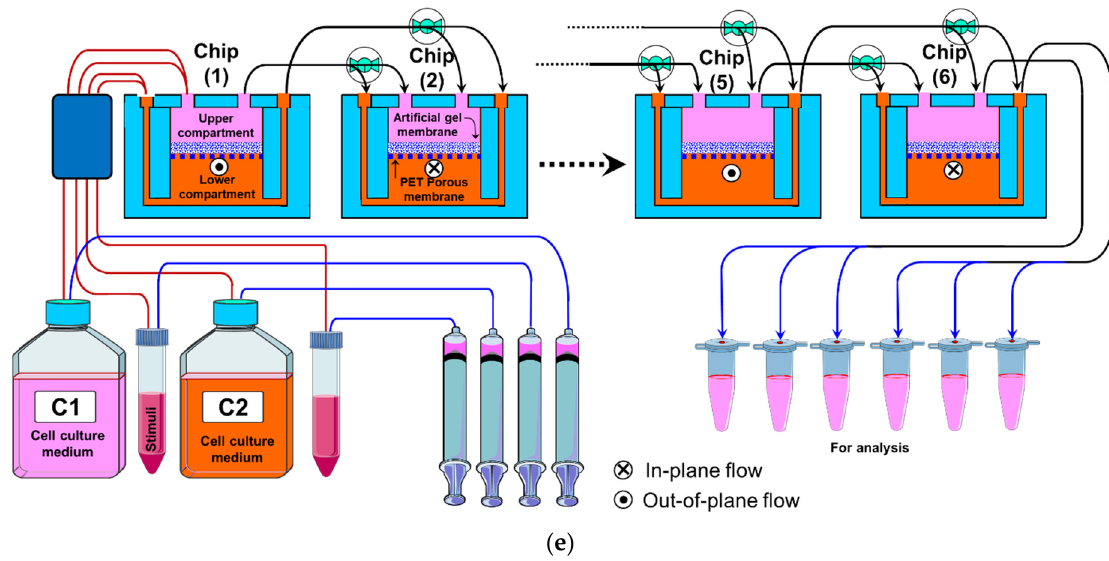
Figure 2. ( a ) Fabrication of the microfluidic chip. The chip was assembled of four PMMA sheets with microfluidic features created using the laser cutting technique. A porous membrane separates the two (upper and lower) microfluidic compartments. Gold electrodes with a diameter of 500 µ m were inserted into the top and bottom cover to access the upper and lower compartment for TEER measurements. ( b ) 3D drawing of the perfusion system with its major components. ( c ) 3D-printed micro valve which was used to regulate the flow within the chip assembly ( d ) An image of the fully assembled perfusion system (colored liquid was used for better visualization). ( e ) The microfluidic chip assembly with an example of possible chip-chip connecting.